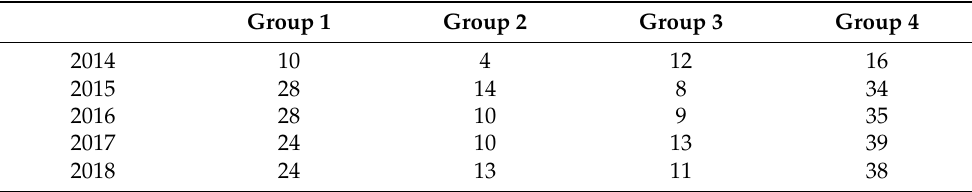
Table 5. Number of regions in the group,